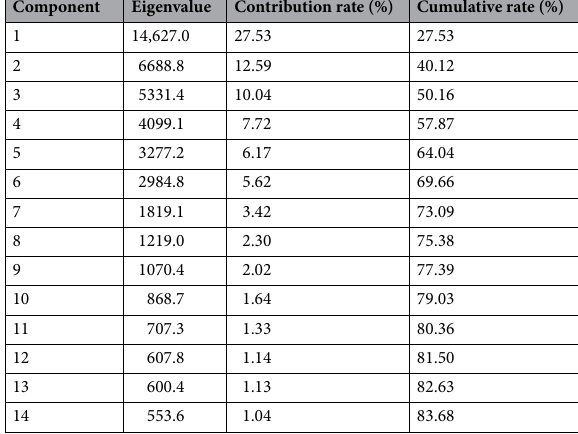
Table 2. Results of PCA adopted to the coordinates data sets of 342 homologous cranial